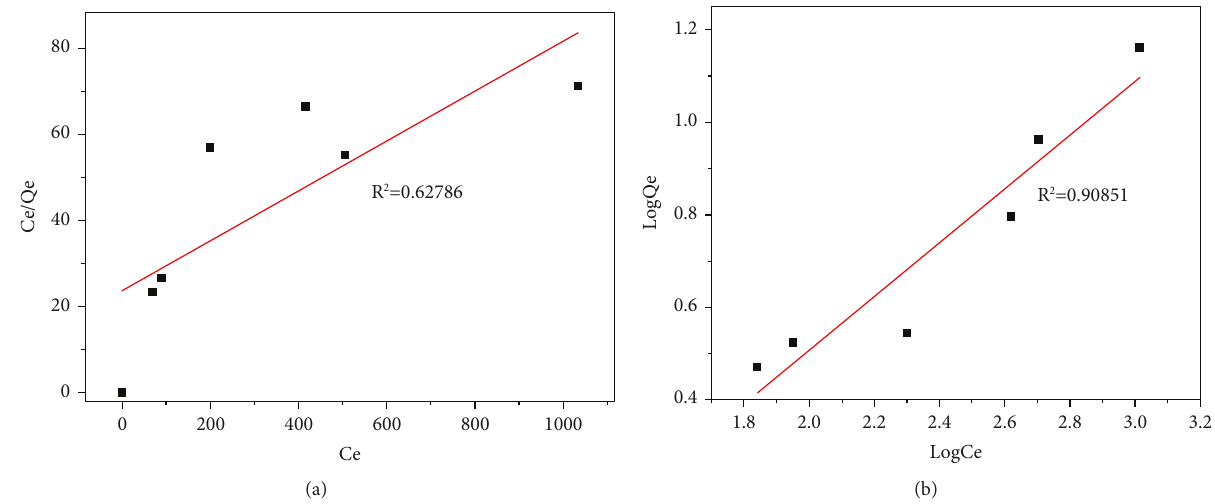
Figure 10: Langmuir plot (a) and Freundlich plot (b) for Ni, Co, and Mn adsorption on DPRC-600 ° C. Table 4: Isotherm constant for the adsorption of Ni, Co, and Mn ions by DPRC-600 ° C. Langmuir Freundlich